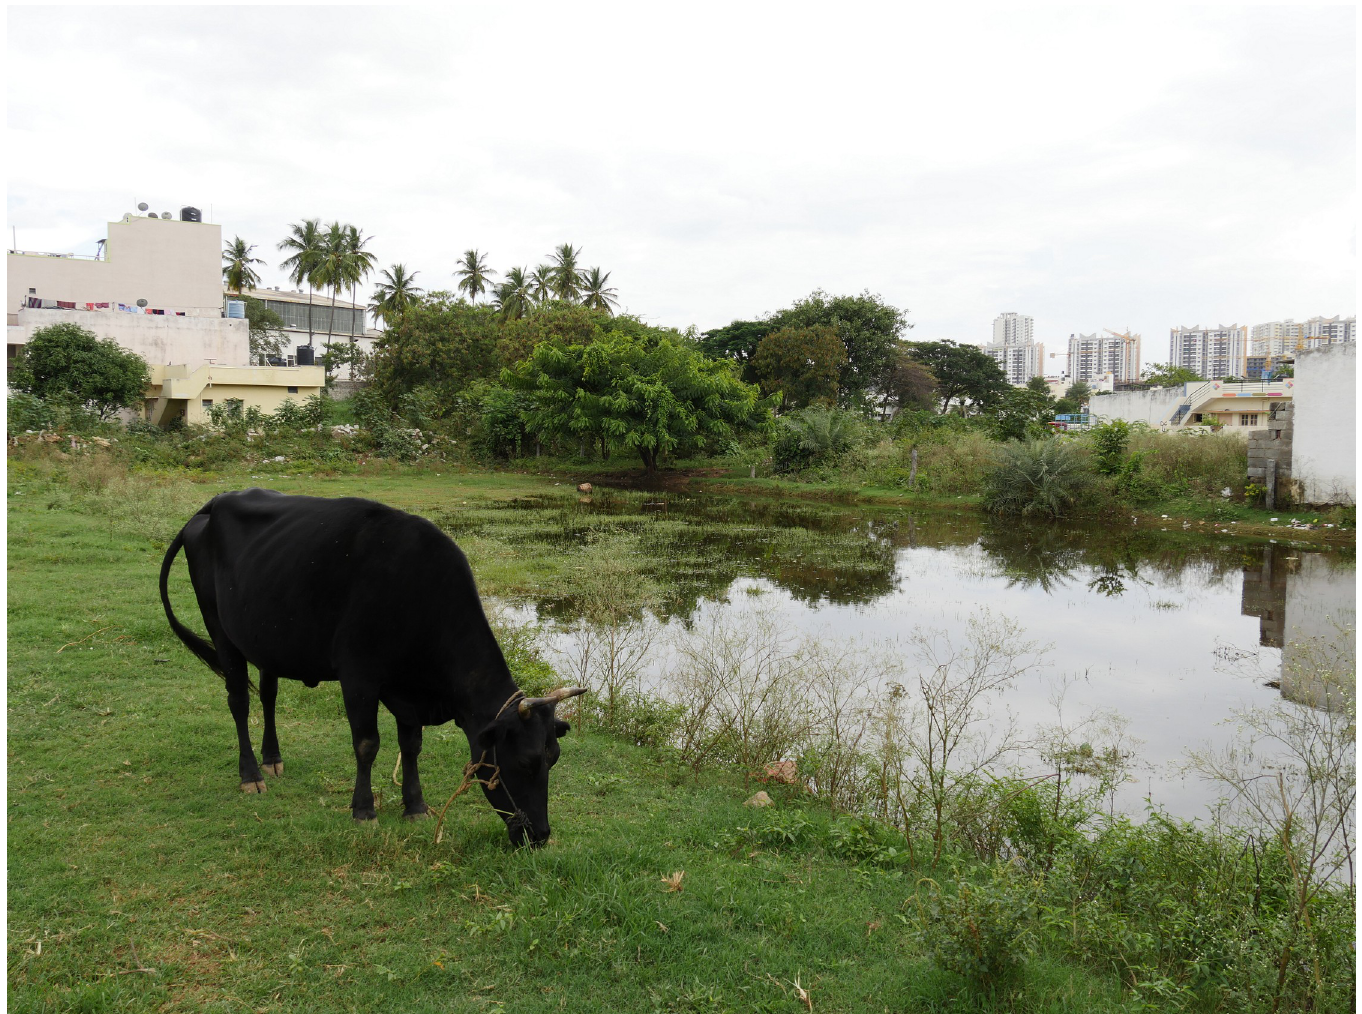
Fig 6. Pictures of dairy cattle in the streets and grazing on green public grounds. All pictures were taken in urban neighborhoods (SSI = 1 or 2).